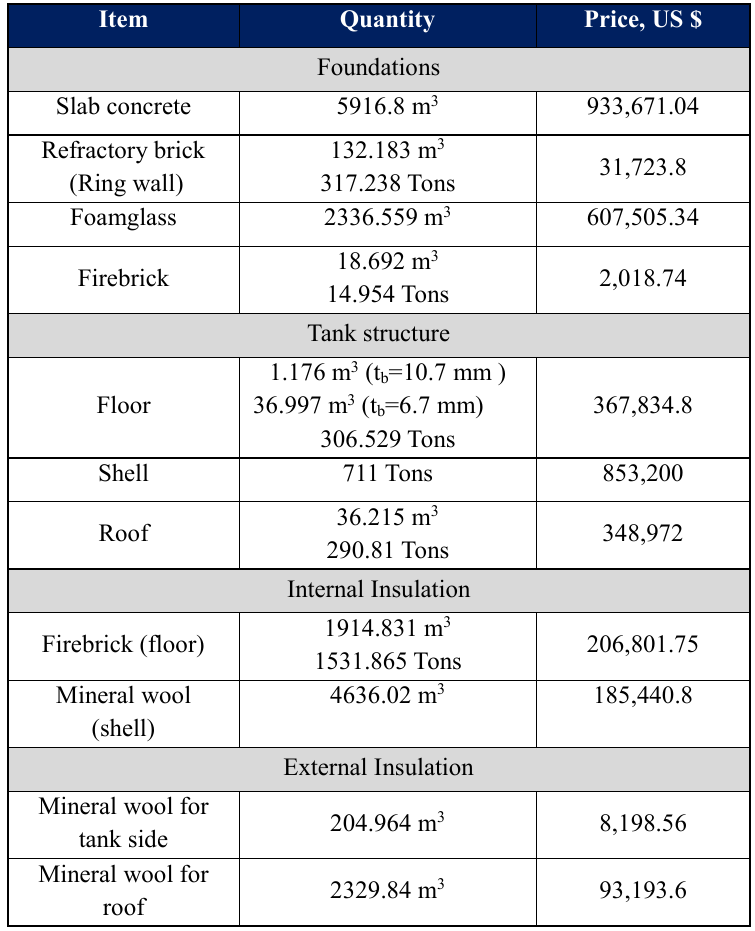
Hot salt tank cost